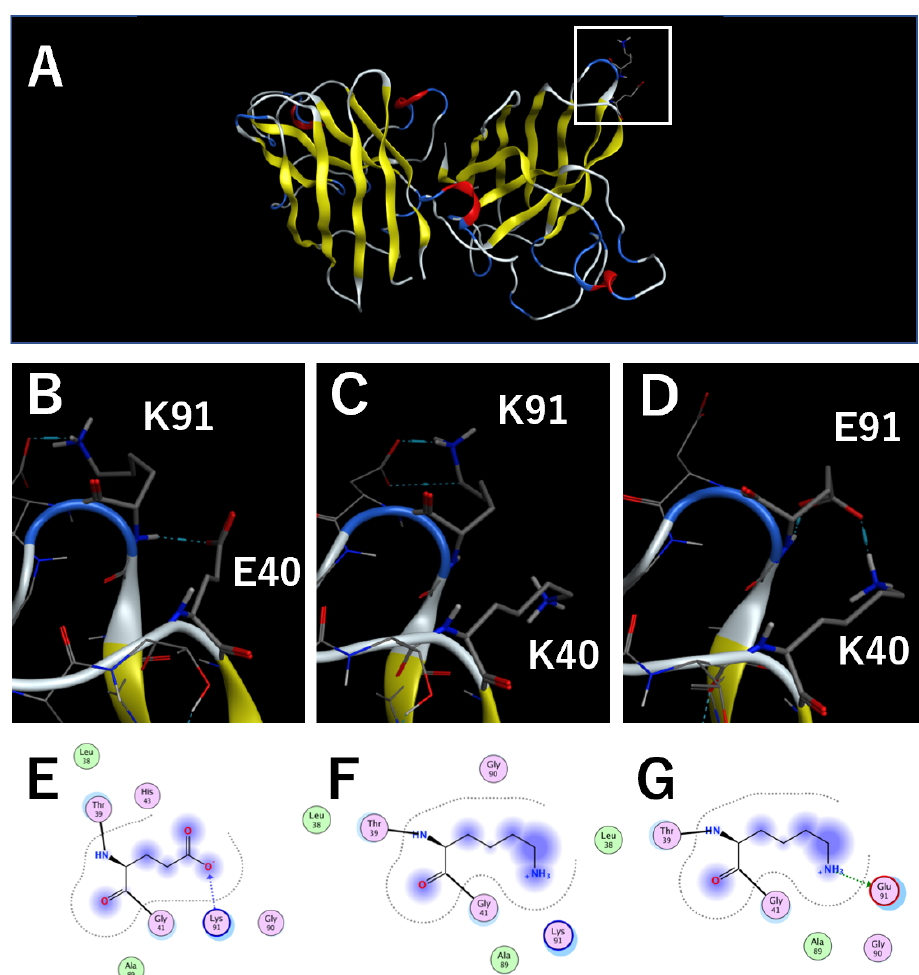
Figure 1. Homology models of cSOD1 WT and mutants. ( A ). The entire cSOD1(WT) dimer structure. α -helix, β -sheet, and turn structures are colored red, yellow, and blue, respectively. ( B ~ D ). Close-up displays of the region around residue 40 of cSOD1(WT) ( B ), (E40K) ( C ), and (E40K,K91E) ( D ) shown in the white square in Figure 1A. The locations of E40 and K91 are noted in one of the two subunits visible in the image. The interaction between residues E40 and K91 are shown by blue dotted lines.